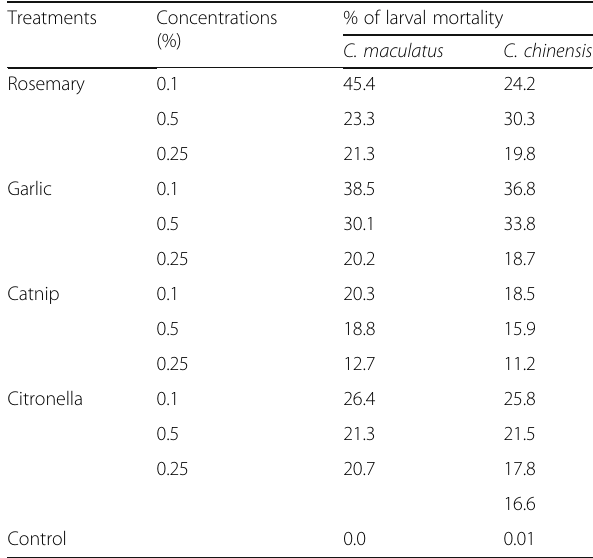
Table 3 The insecticidal efficacy of the oils tested on larval mortality% of the target pests Treatments Concentrations (%)